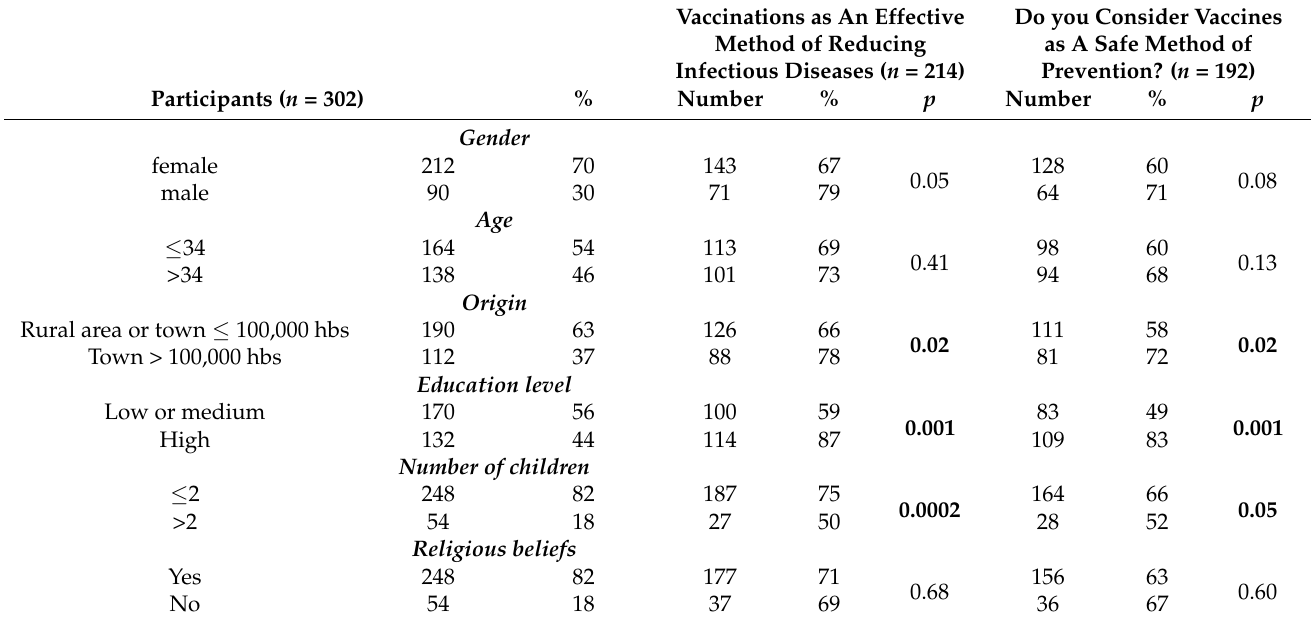
Table 2. General participants’ attitude towards vaccines.